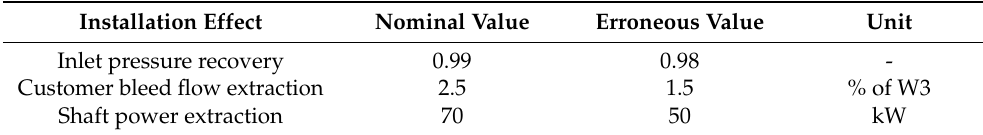
Table 5. Installation effect nominal and erroneous values.